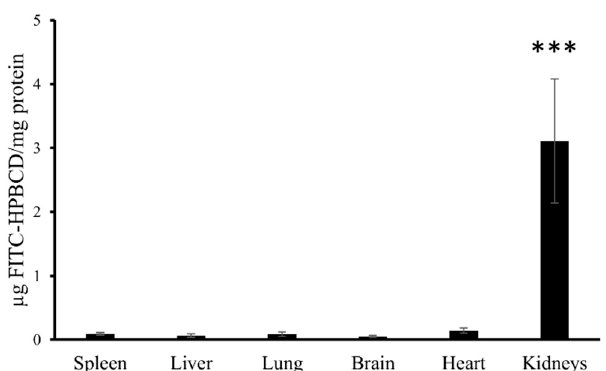
Figure 2. FITC-HPBCD content in the supernatant of the tissue homogenates of mice. FITC-HPBCD was administered i.v. and after 60 min of treatment significant fluorescence intensity could be measured only in the supernatant of kidney homogenates (*** p < 0.001).